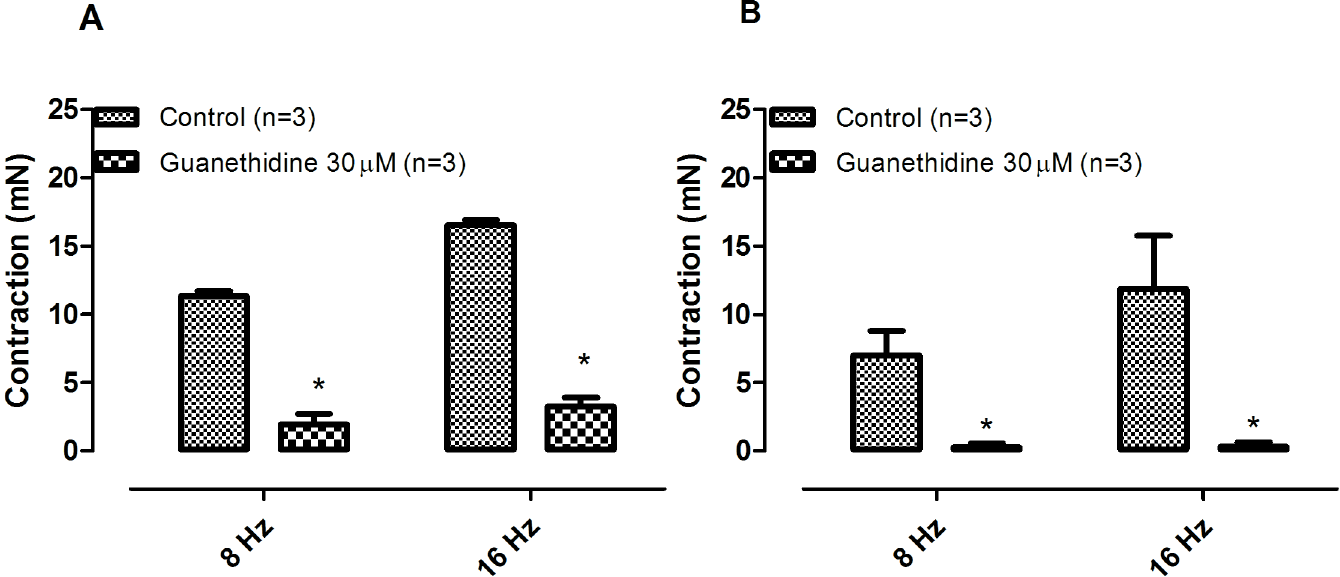
Fig 2. Effect of guanethidine(30 μ M) on EFS-induced contractions on corpora cavernosaisolatedfrom Crotalus (A) and Rabbit (B) . Data are expressed as mean ± standard error mean (S.E.M). * P < 0.05 vs control (paired Student’s t test).